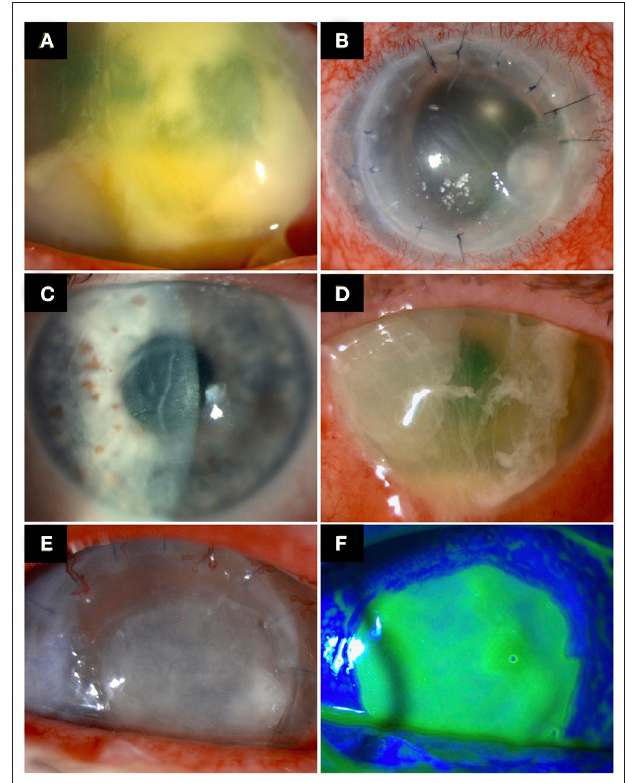
FIGURE 1 | Examples of post-keratoplasty infectious keratitis (PKIK). (A) A case of PKIK caused by Streptococcus pneumonia in an eye after Descemet membrane endothelial keratoplasty, while on topical corticosteroids. (B) A case of suture-related PKIK caused by Staphylococcus aureus in an eye after penetrating keratoplasty. (C,D) A case of PKIK caused by Pseudomonas aeruginosa in an eye with failed Descemet stripping automated endothelial keratoplasty with bullous keratopathy, while on topical steroids. (C) demonstrates the presence of decompensated corneal graft prior to the infection. (E,F) A case of PKIK caused by Moraxella catarrhalis in an eye with failed penetrating keratoplasty with bullous keratopathy, while on topical